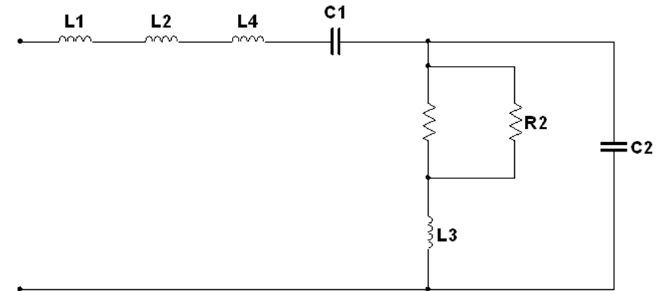
Figure 3. Circuit model at X-band.